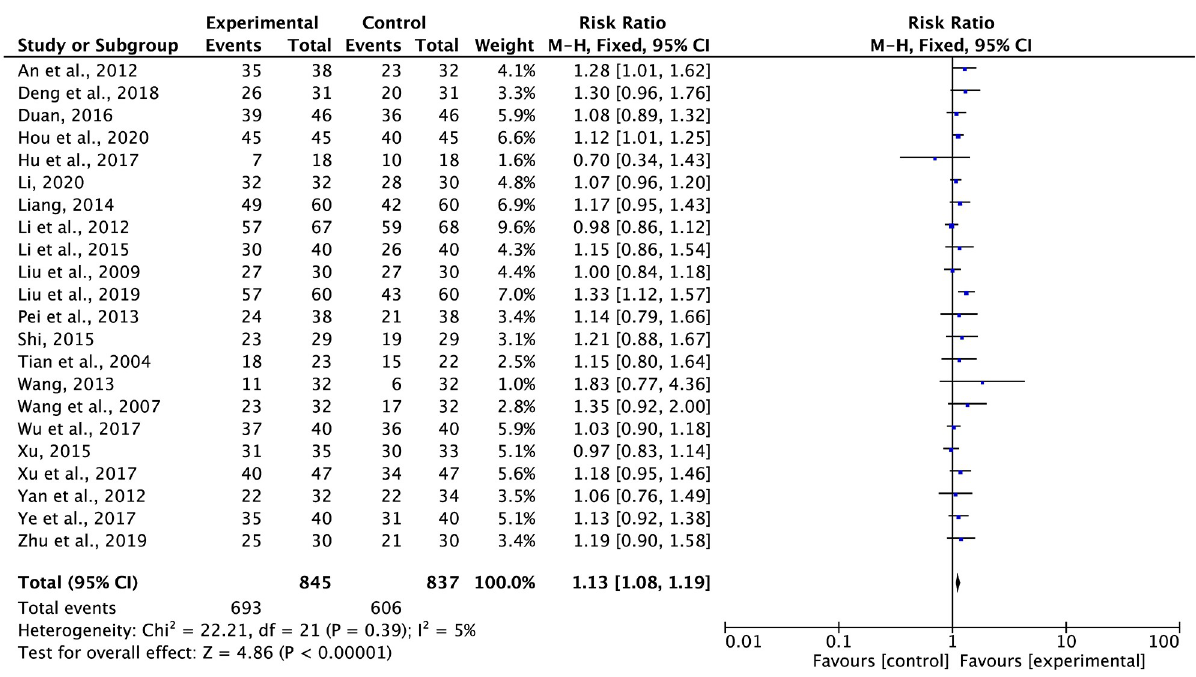
Fig 4. Meta-analysis results of